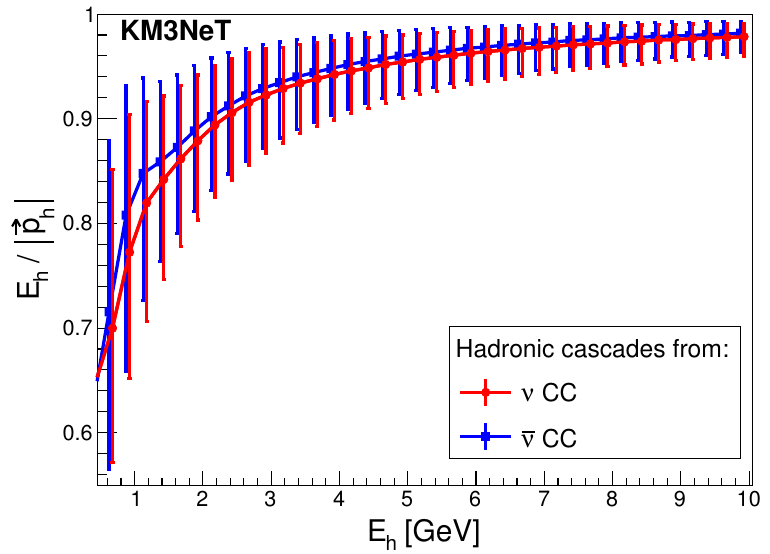
Figure 9 . Ratio E h = j ~p h j (calculated according to eq. (2.1)) as a function of E h , for hadronic cascades extracted from both (cid:23) CC (red) and (cid:23) CC (blue) events. Error bars represent the variation characterised by the RMS. Note that the de(cid:12)nition of p h (cid:17) q (eq. (2.1), and (cid:12)gure 1) requires j ~p h j > E h , since q 2 is negative.